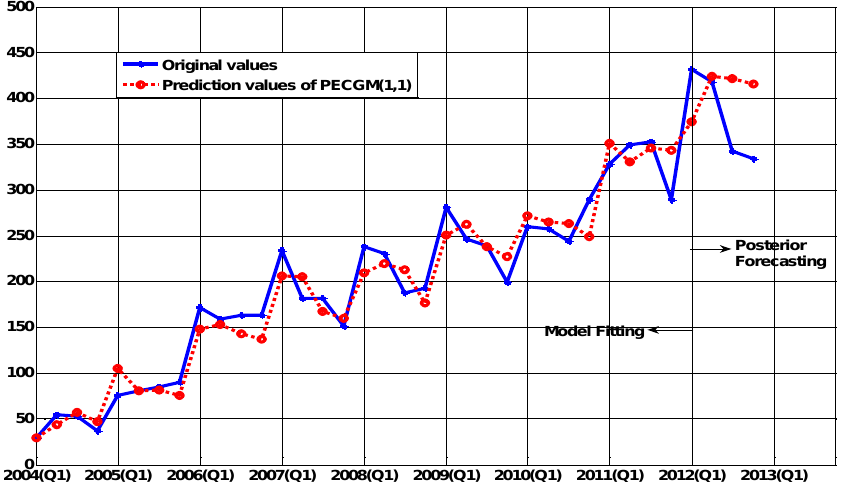
Figure 2. The comparison between the real values and the simulation values of the PECGM(1,1) model.